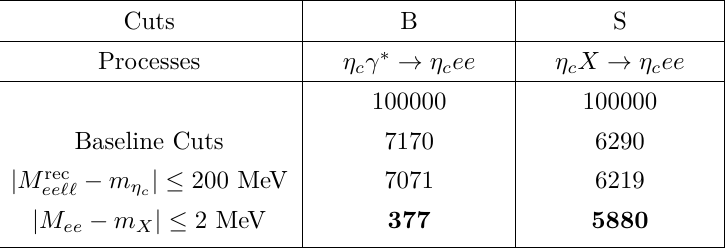
Table 3 . Signal and background events of e + e − → ‘ + ‘ − e + e − η c after cuts at Belle II.